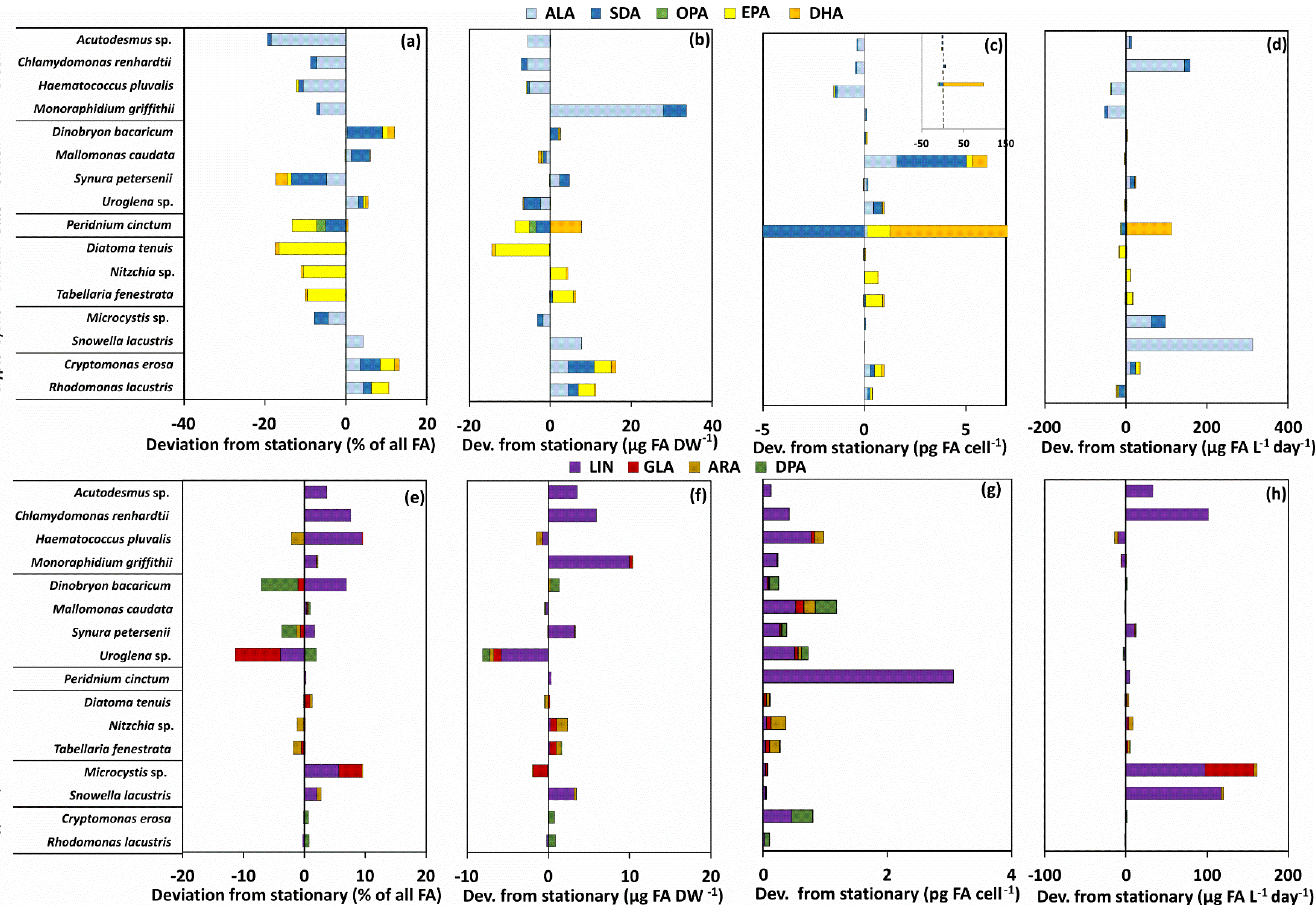
Figure 3. The deviation of ω - 3 (ALA, SDA, OPA, EPA, DHA) and ω -6 (LIN, GLA, ARA, DPA) PUFA between exponential and stationary phases: proportion of all fatty acids ( a , e ), per biomass content ( b , f ), per cell content ( c , g ), and daily production ( d , h ).